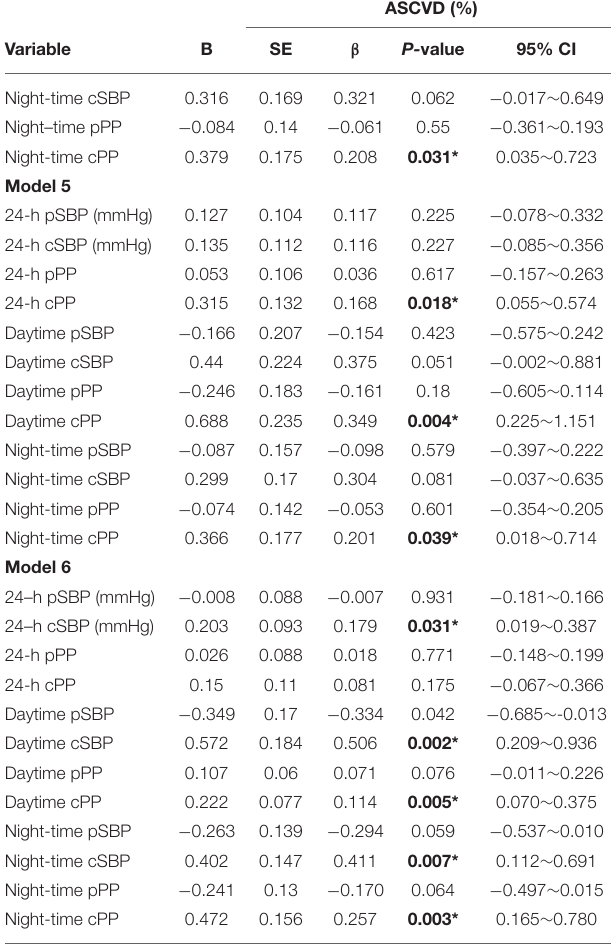
pSBP, Peripheral systolic blood pressure; cSBP, Aortic systolic blood pressure; pPP, Peripheral pulse pressure; cPP, Aortic pulse pressure. Model 1 adjusting for Age, Sex, BMI. Model 2 adjusting for Age, Sex, BMI, Antihypertensive treatment. Model 3 adjusting for Age, Sex, BMI, Antihypertensive treatment, Smoker. Model 4 adjusting for Age, Sex, BMI, Antihypertensive treatment, Smoker, Triacylglycerol. Model 5 adjusting for Age, Sex, BMI, Antihypertensive treatment, Smoker, Triacylglycerol, Statin treatment. Model 6 adjusting for Age, Sex, BMI, Antihypertensive treatment, Smoker, Triacylglycerol, Statin treatment, Glucose, Hypoglycemic therapy, HR. The symbol * and bold values represent the values that are statistically significant (P <